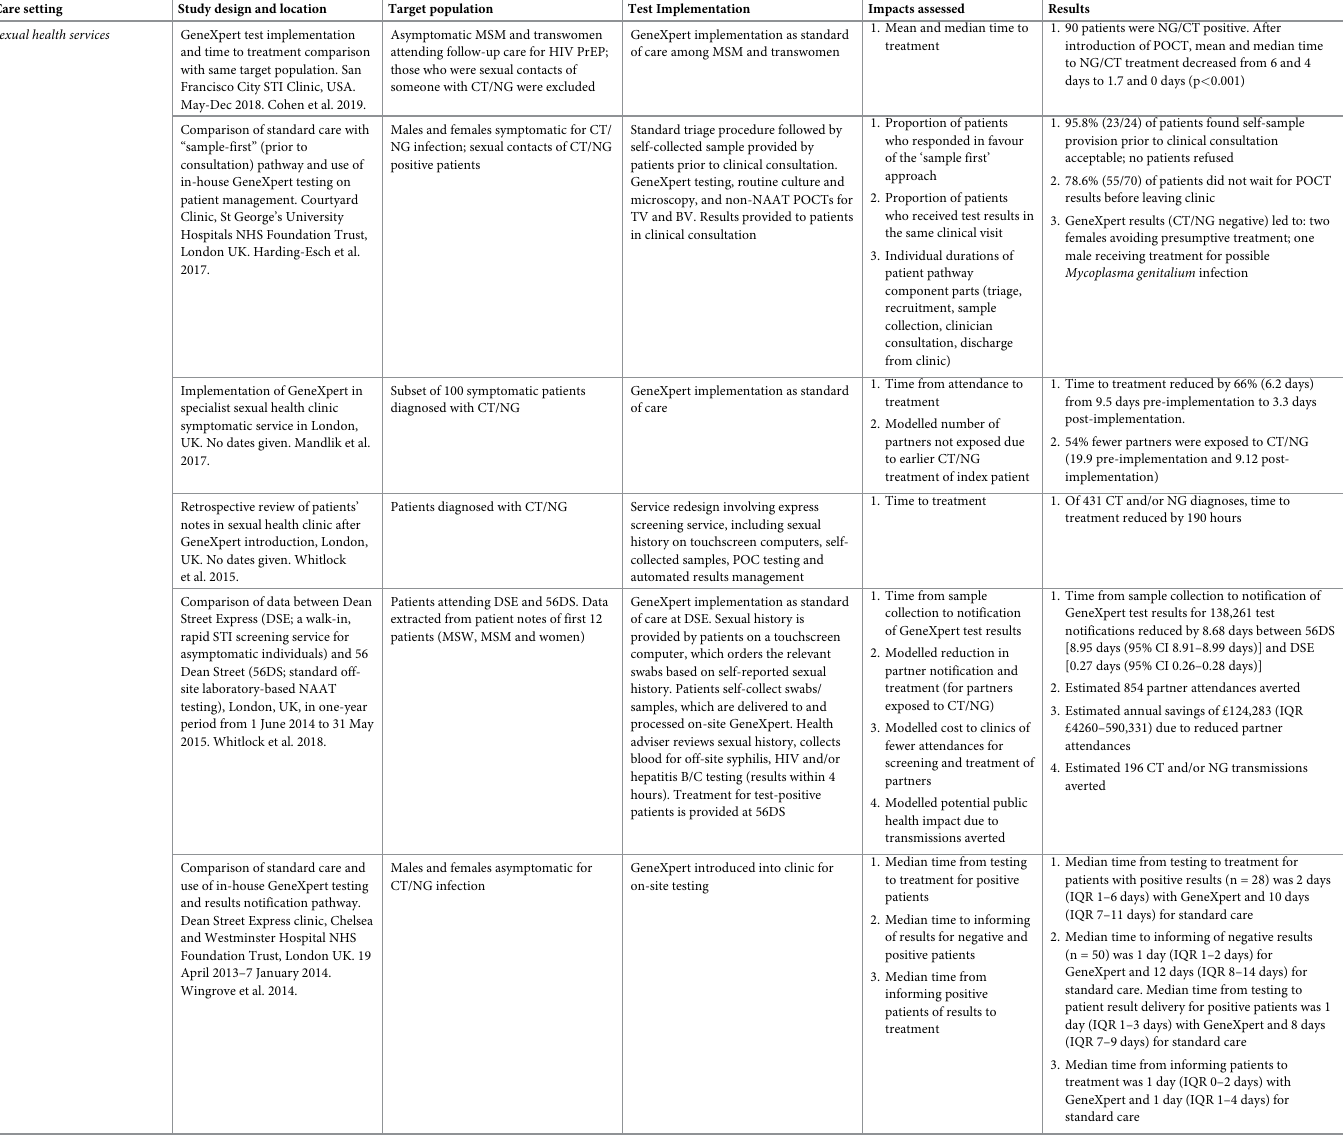
Table 3. Routine implementation of the Cepheid CT/NG GeneXpert in different healthcare service settings.